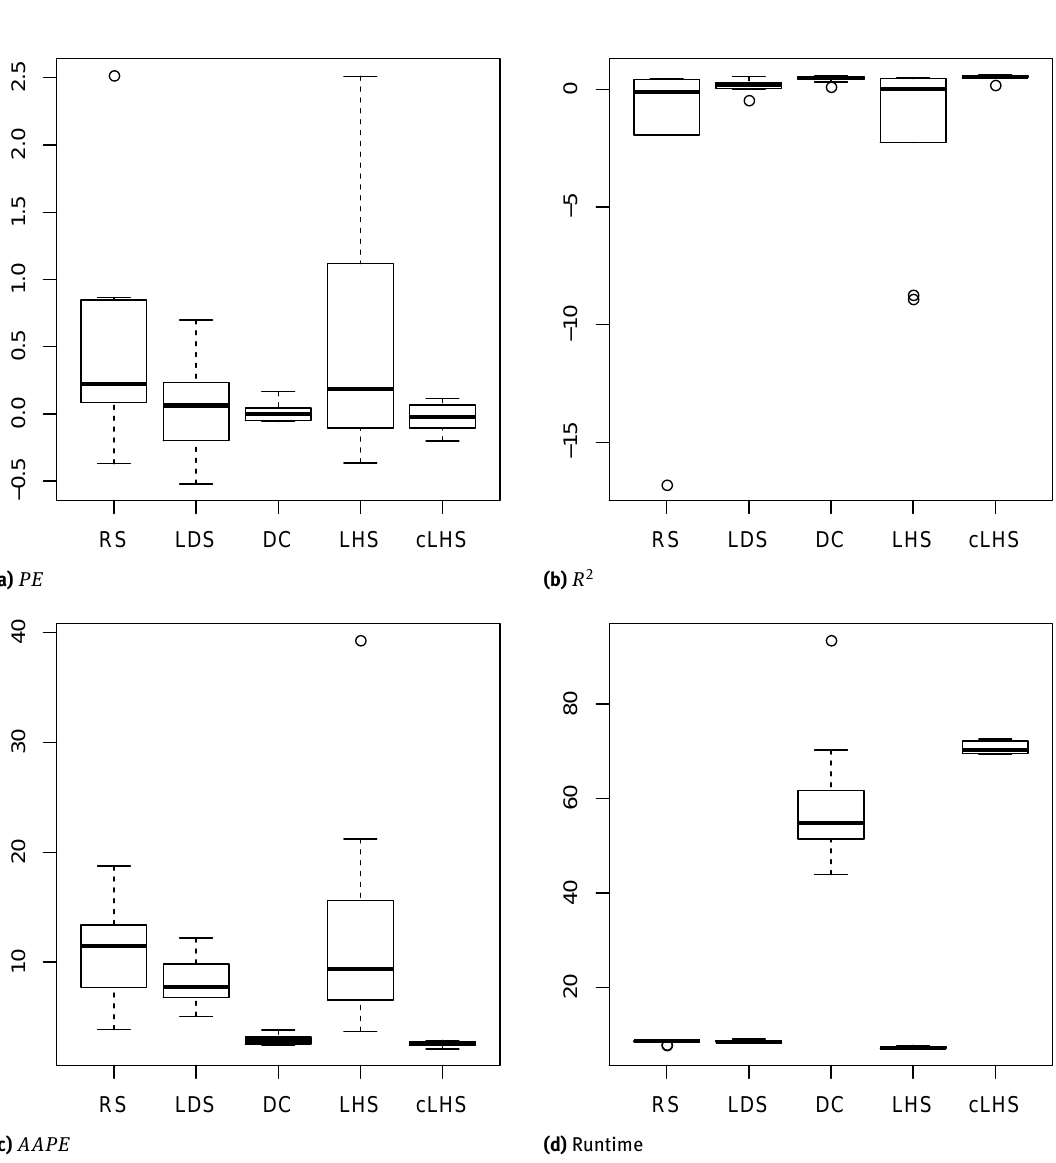
Figure 4: Box plots of the performance measures from 10 runs of the experimental design methods when s = 220